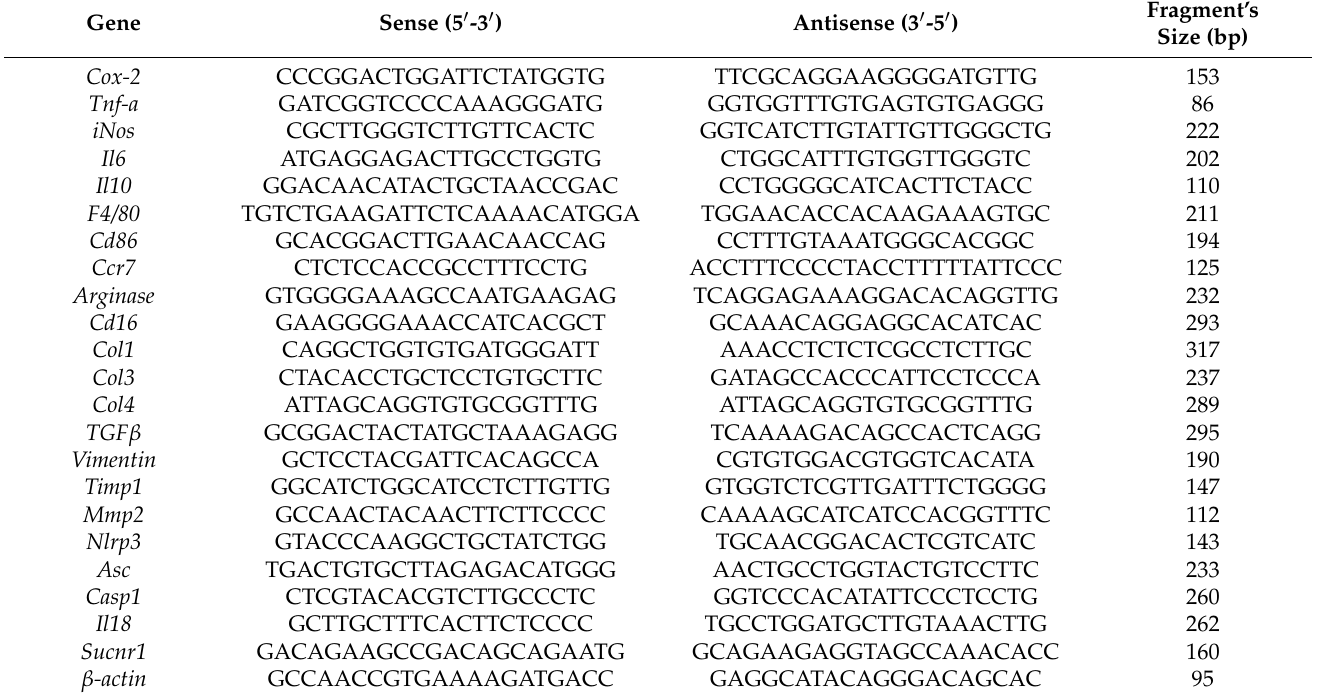
Table 4. Sequences of mouse primers used in real-time